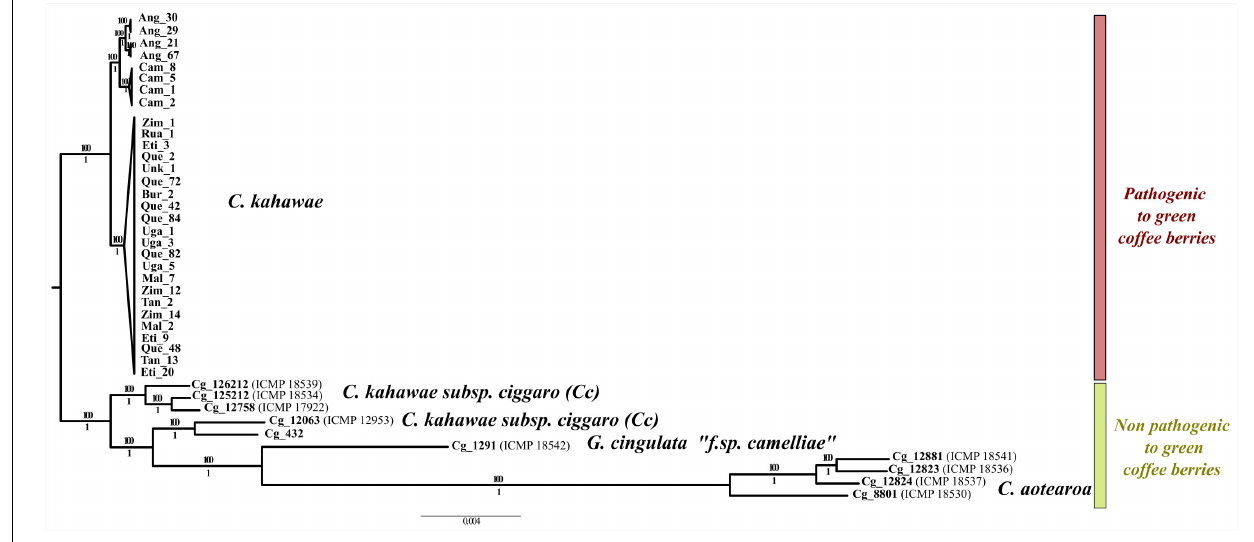
maximum shared heterozygosity of 3. Additional filtering